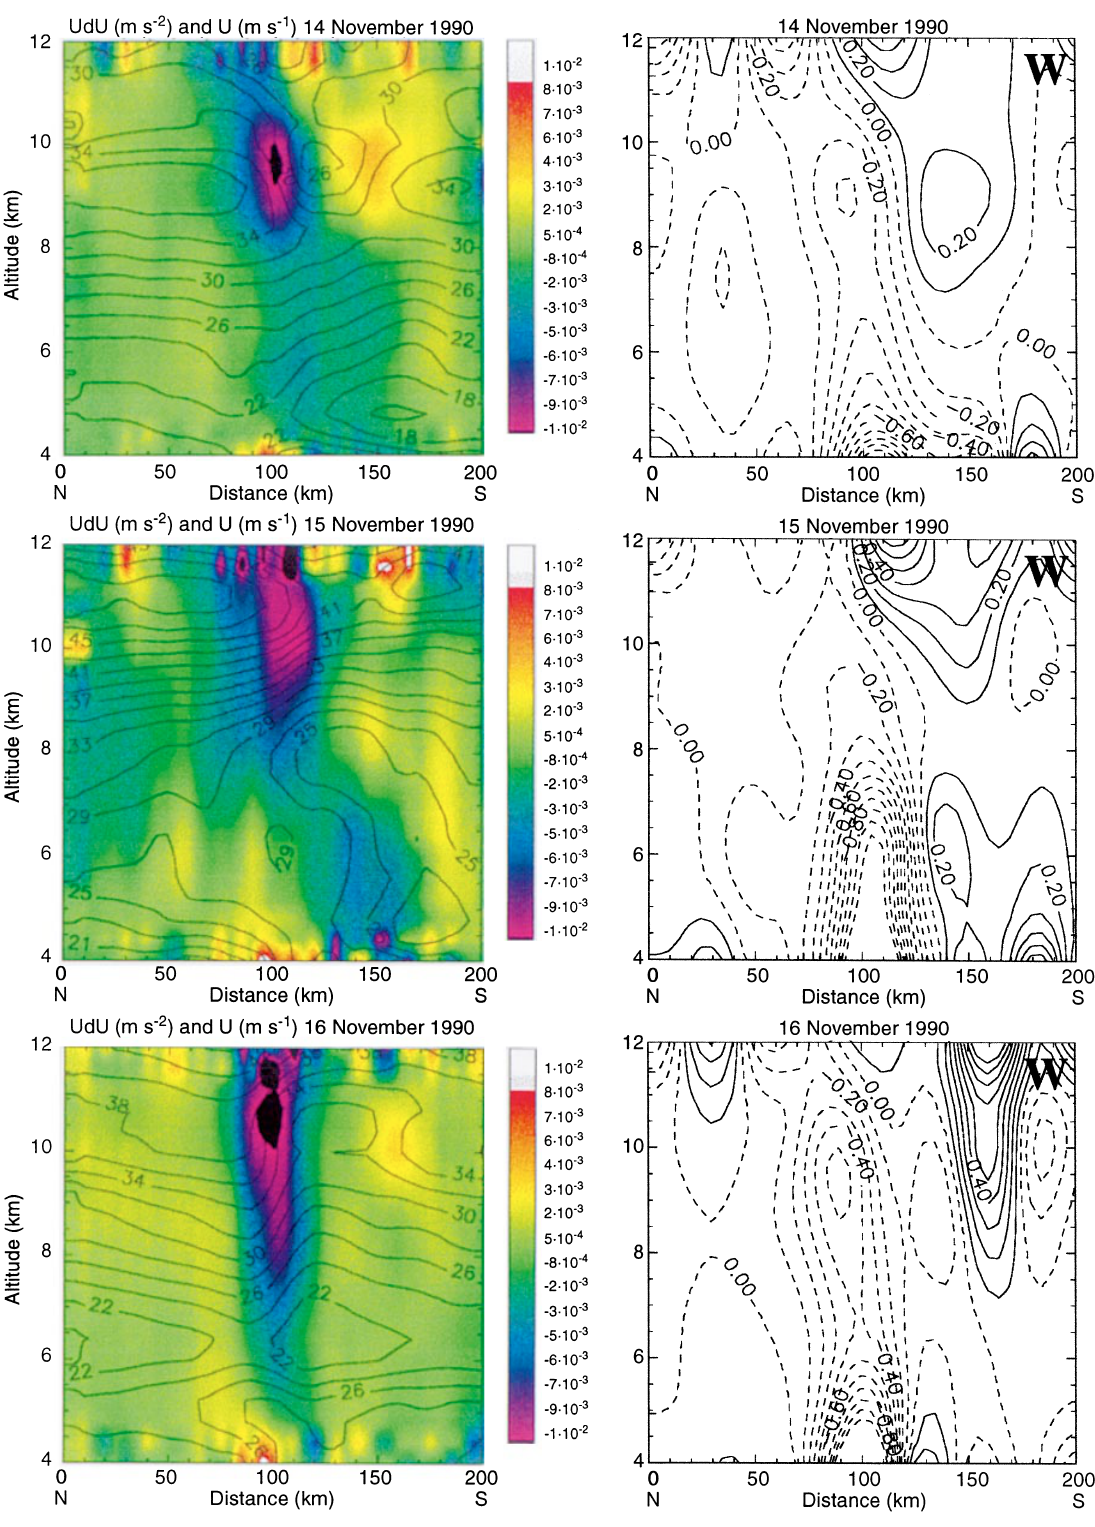
Fig. 16. Left : horizontal advection of wind ( colors ) (in m s (cid:255) 2 ) superimposed on wind component field ( black isolines ); right : vertical velocity ( solid lines for upward velocities and dashed lines for downward ones) (in m s (cid:255) 1 ); from top to bottom : examples of 14, 15 and